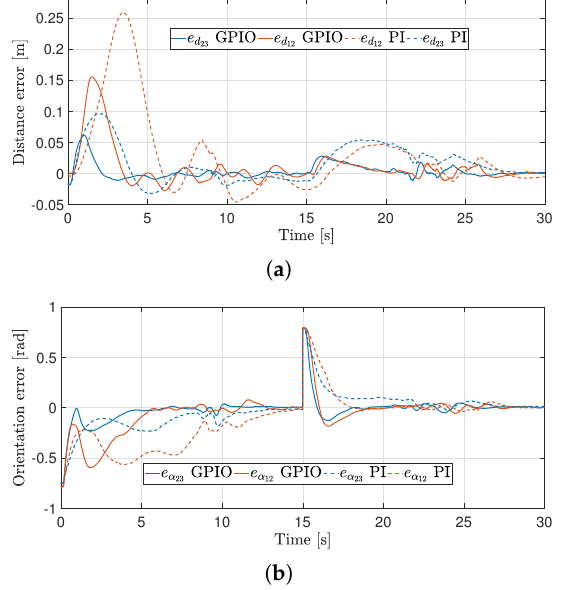
Figure 14. Distances and orientation angles errors for the second experiment. ( a ) Distance error. ( b ) Orientation error.